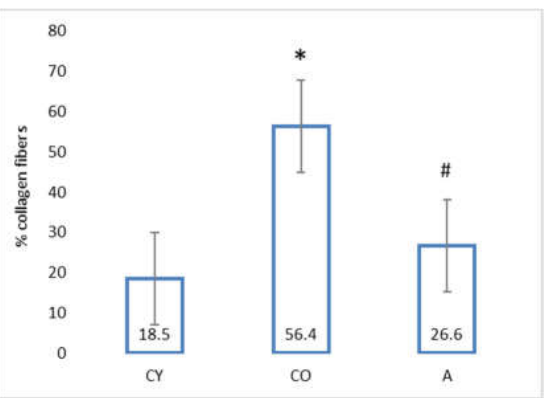
Figure 3. Percentage of collagen fiber distribution in the coronary tunica media of rat heart. * CO vs. CY, p < 0.05, # A vs. CO, p < 0.05.